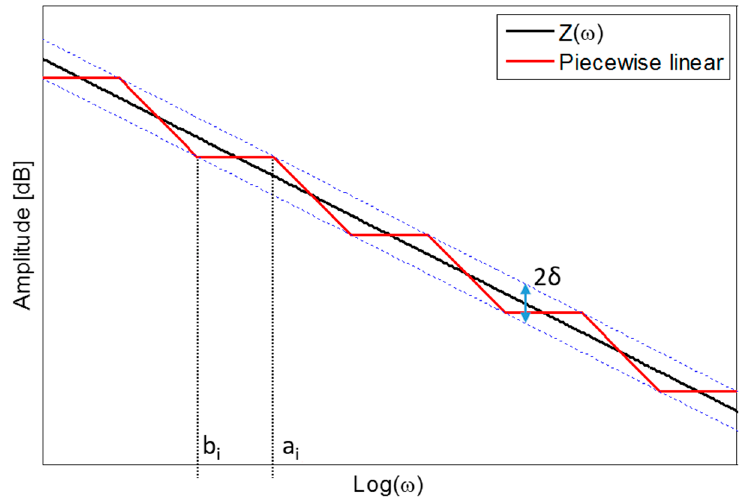
Figure 1. Example of amplitude behavior of the operator Z ( ω ) and the piecewise function.